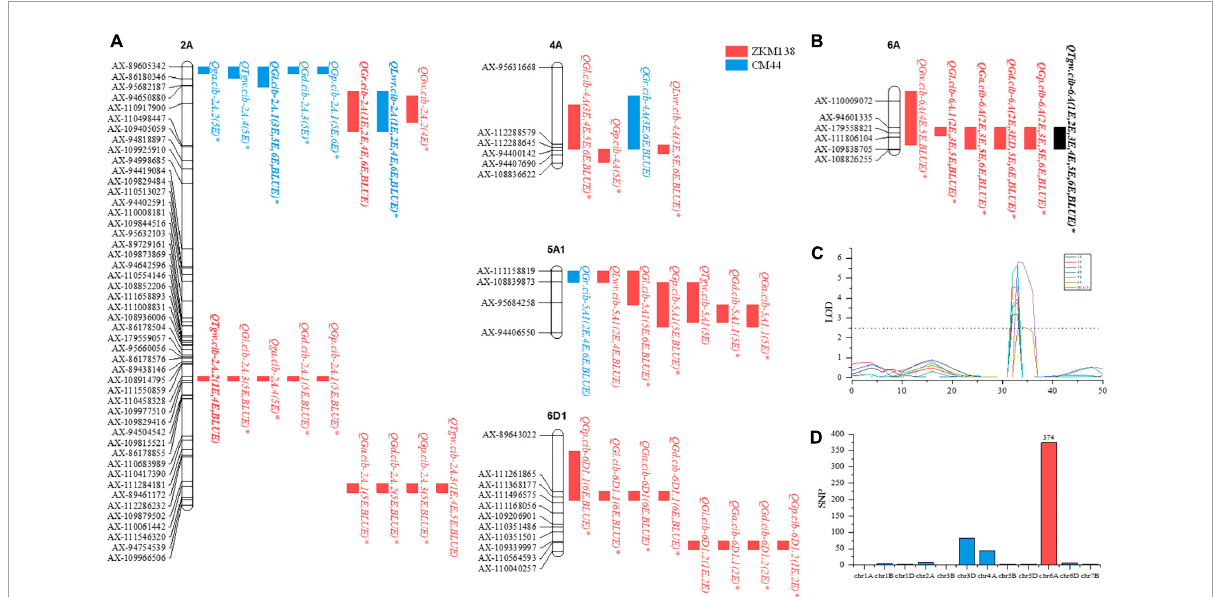
FIGURE2 The highlighted QTL regions for TGW and GRTs. (A) Summary of QTL clusters detected in the BC-RILs (except C6A). (B) The target QTL cluster on chromosome 6A (C6A). (C) The LOD value of the major stable QTL ( QTgw.cib-6A ) for TGW in the BC population. The dotted line represents a logarithm of the odds (LOD) = 2.5. (D) Identification of candidate SNPs using BSR-Seq. (cid:49) (SNP-index) > 99%.